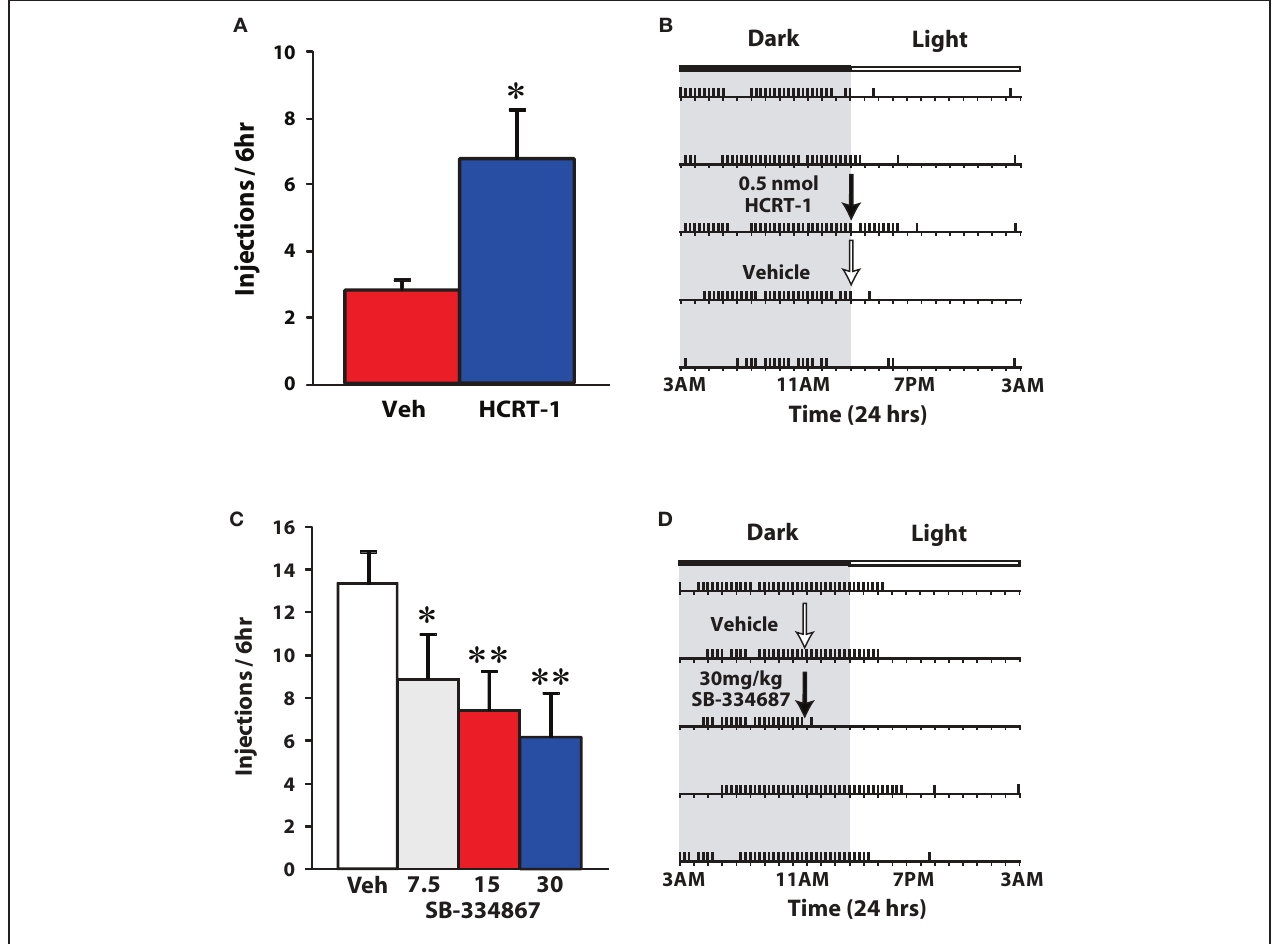
FIGURE 4 | Hypocretin signaling regulates cocaine self-administration on a DT schedule of reinforcement. (A) Shown are the mean ± SEM number of cocaine injections taken over the 6h period following infusion of vehicle ( n = 7) or 0.5nmol hypocretin-1 (HCRT-1; n = 7). (B) Shown is a response pattern from an individual rat that received vehicle (white arrow) or 0.5nmol hypocretin-1 (black arrow) into the lateral ventricle. (C) Shown are the mean ± SEM number of cocaine injections taken over the 6h period following i.p. injections of vehicle ( n = 8) or SB-334867 (7.5, 15, and 30mg/kg; n = 8). (D) Shown is a response pattern from an individual rat that received